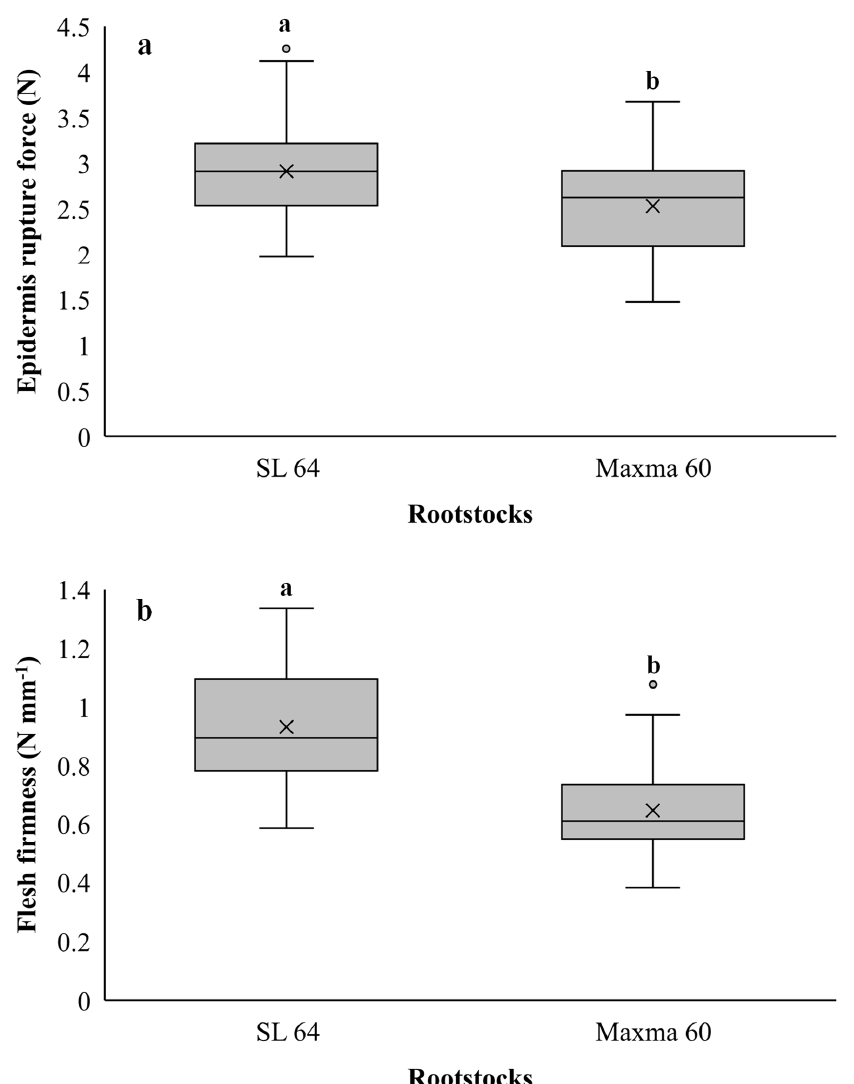
Figure 3. ( a ) Epidermis rupture force (ERF) and ( b ) flesh firmness (FF) of sweet cherry cv. Early Bigi grafted on SL 64 and Maxma 60 rootstocks. Different letters indicate statistically significant differences ( p < 0.05) according to Duncan’s test. The circles represent the outliers.